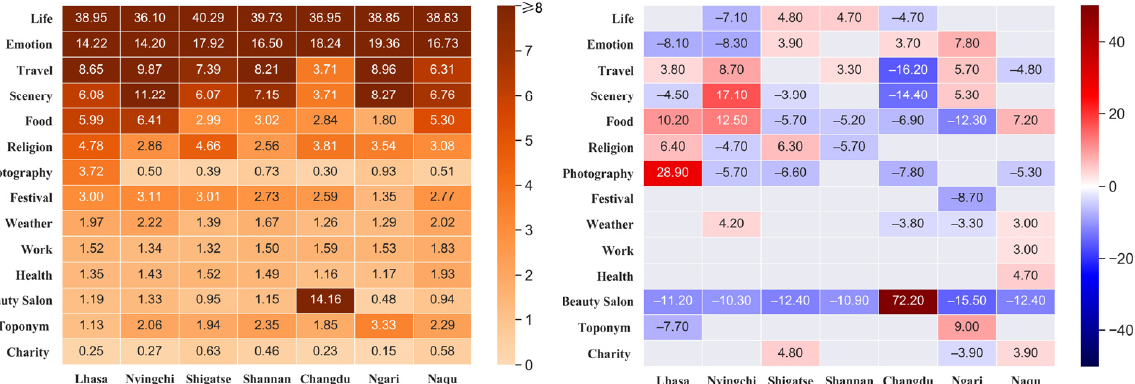
Figure 7. Distributions and adjusted standardized Chi-square residuals for the top 20 topics in the Tibetan resident dataset by city (unit: %).